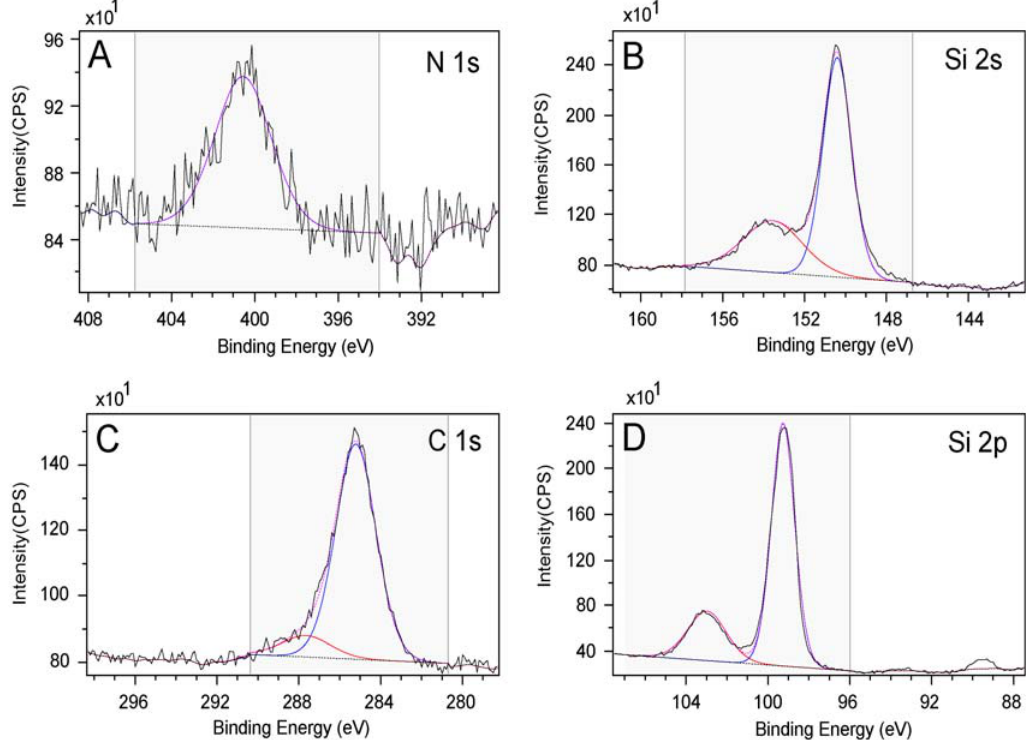
Figure 9. XPS spectra of a APTES monolayer covered SiO (C), and (D) are the XPS regions corresponding to element components of N 1s, Si 2s, C 1s and Si 2p,